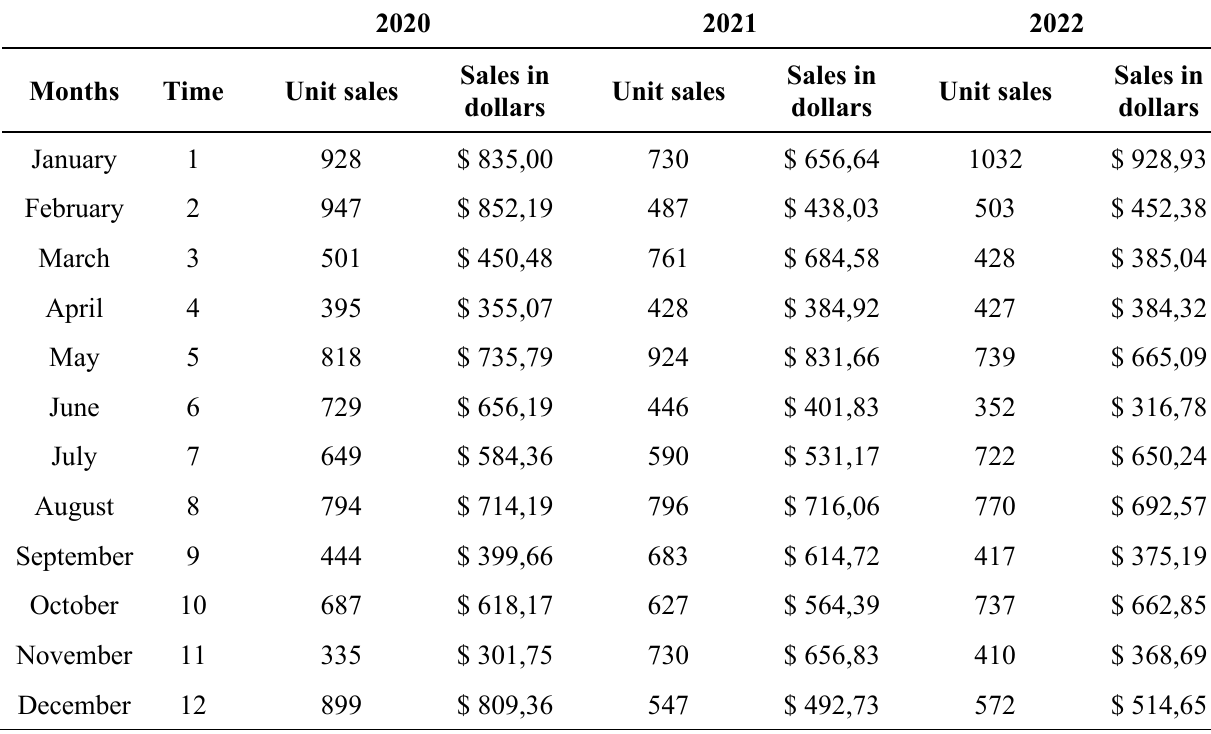
Table 3. Simulation by neural networks of Product